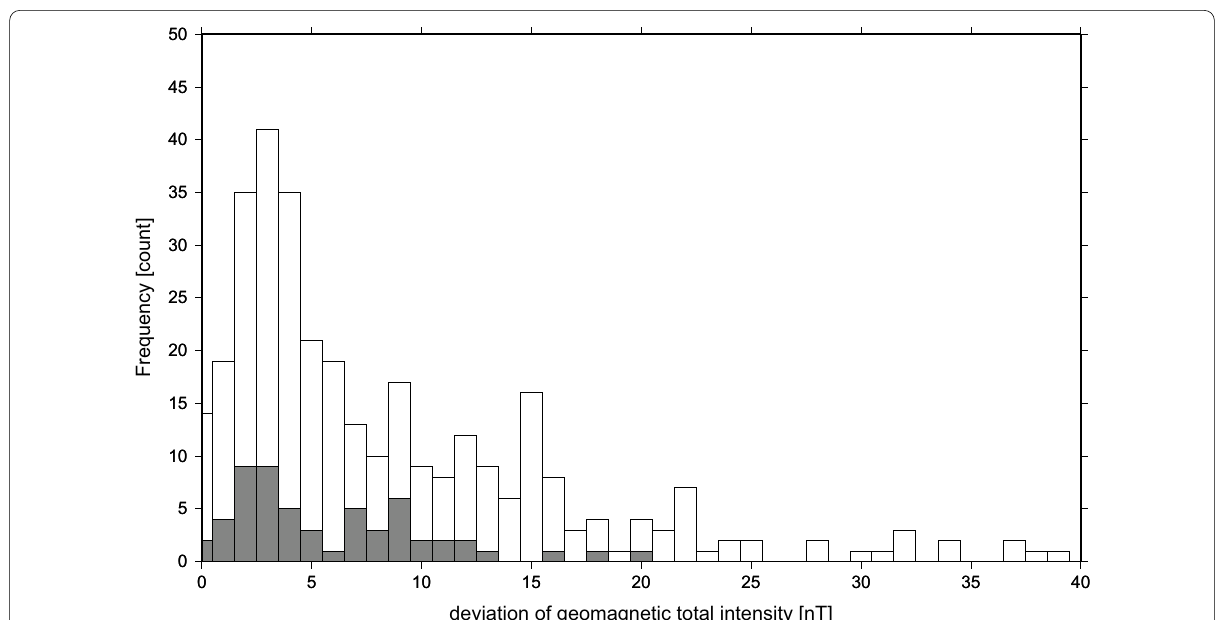
Fig. 5 Deviation of measured geomagnetic total intensity data between a pair of points closer than 5 (in gray color) and 10 (in white color) m of each other, which shows repeatability of data acquisition by unmanned